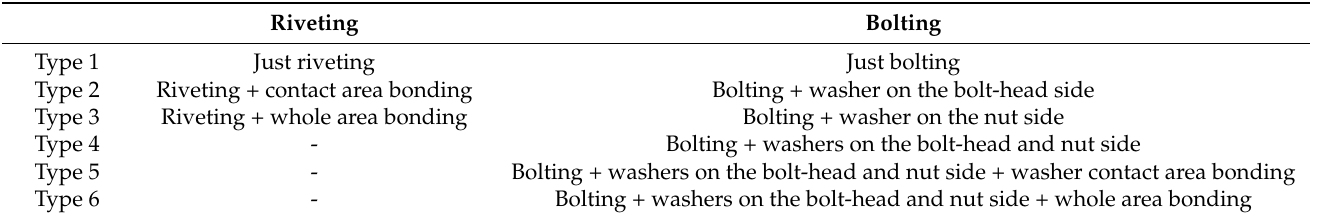
Figure 1. Schematic of the mechanical bonding between CFRP and steel plates: ( a ) riveting/bolting and ( b ) hybrid mechanical bonding with adhesive.